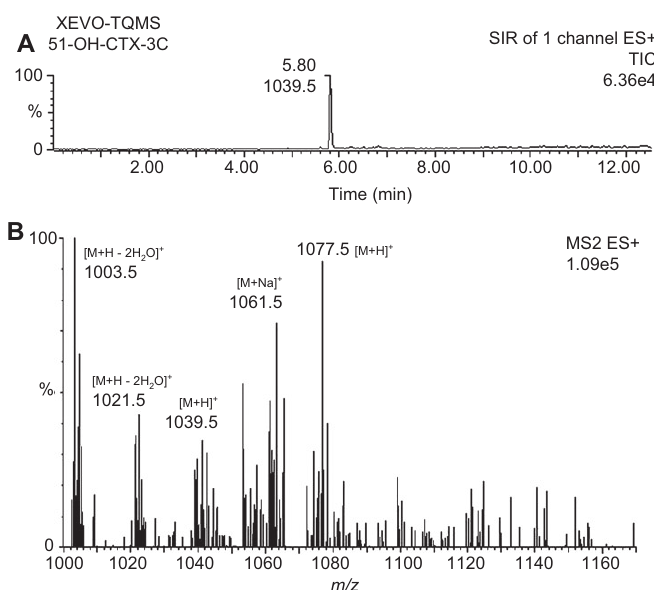
Figure 3 Chromatogram (A) and mass spectrum (B) of 51-OH-CTX-3C ( M 1038.5) standard at 1000 ng/ml, using selected ion recording r (SIR) UPLC mode of 1039.5 m/z [M + H] + . Analysis was performed in an ACQUITY UPLC system coupled with Xevo TQ MS mass spectrometer. column (100 × 2.1 mm; 1.7 μ m). The mobile phase consisted Chromatographic identification was achieved in a Waters Acquity UPLC BEH C 18 of two components: acetonitrile/water (95:5) (A) and water (B), both containing 50 m m formic acid and 2 m m ammonium formate using a gradient elution. 51-OH-CTX-3C, 51-hydroxy-CTX-3C; UPLC, ultraperformance liquid